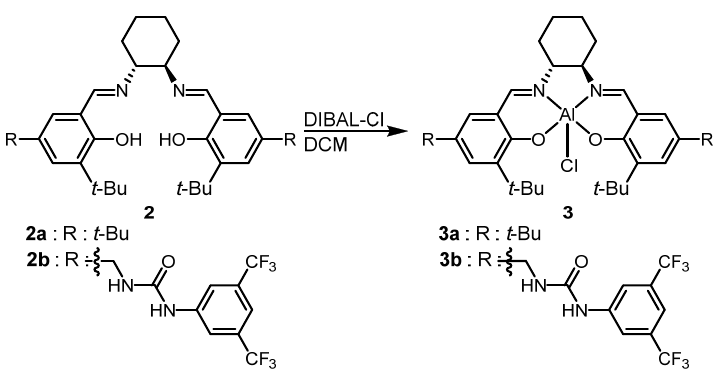
Figure 2. Synthesis of salen-aluminum catalysts.